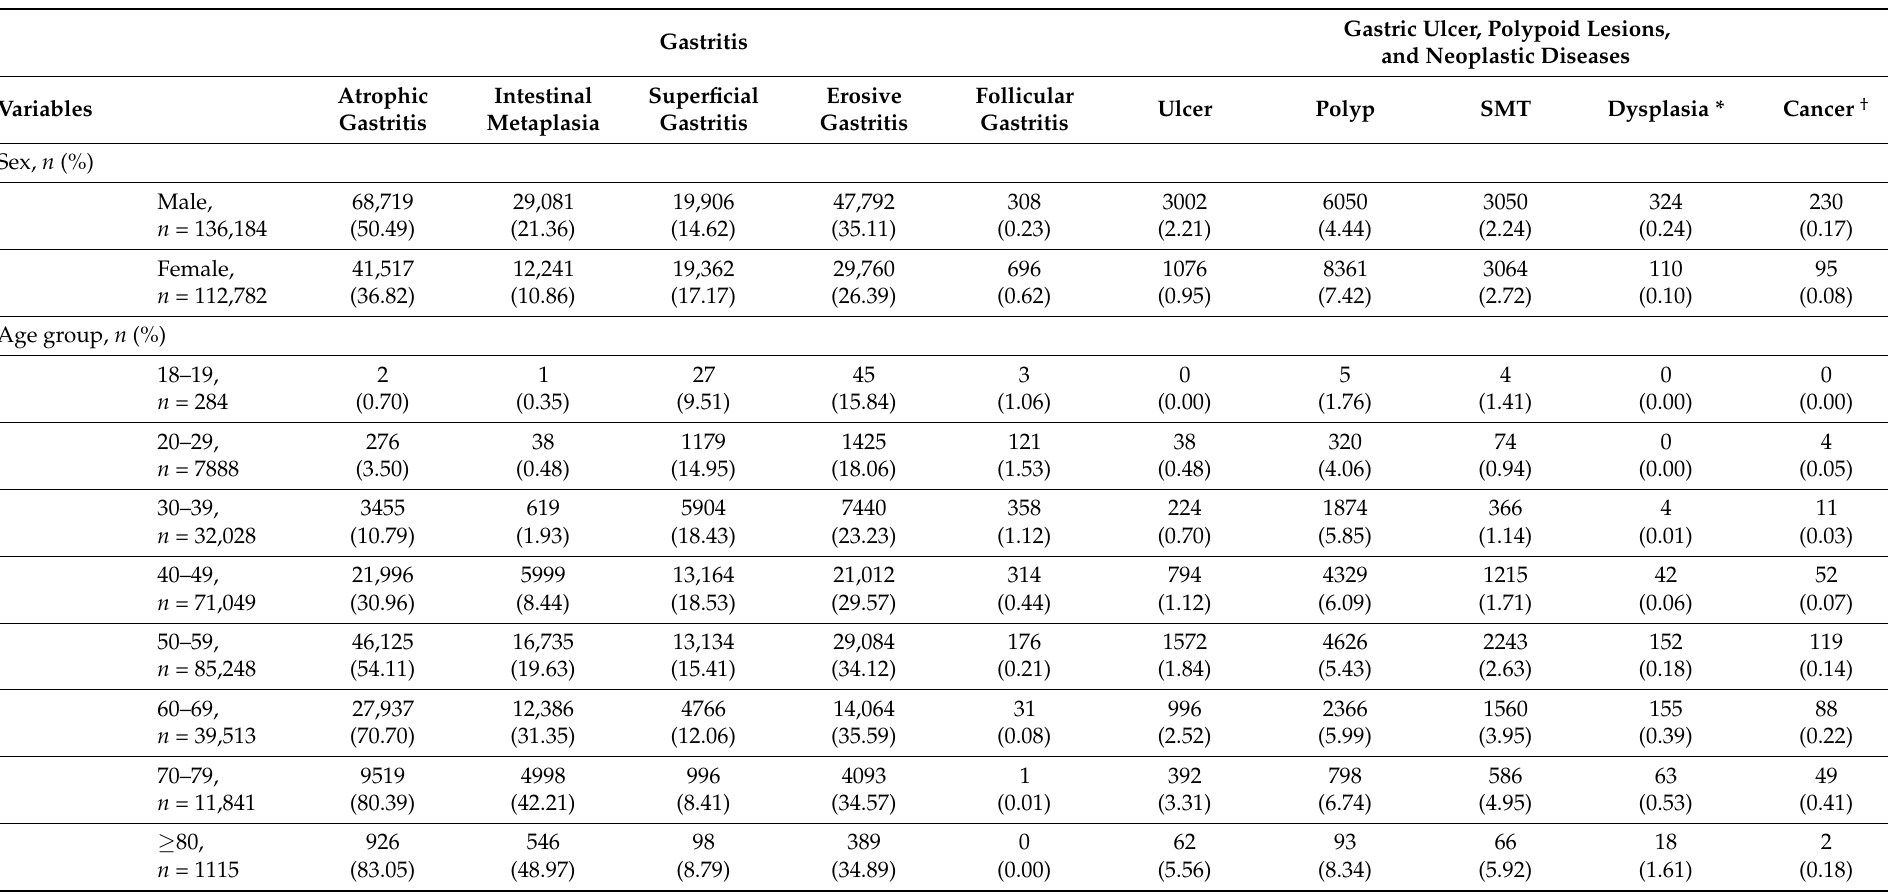
Table 4. Prevalence of gastritis, gastric ulcers, polypoid lesions, and neoplastic diseases by sex and age between 2010 and 2019 ( n =